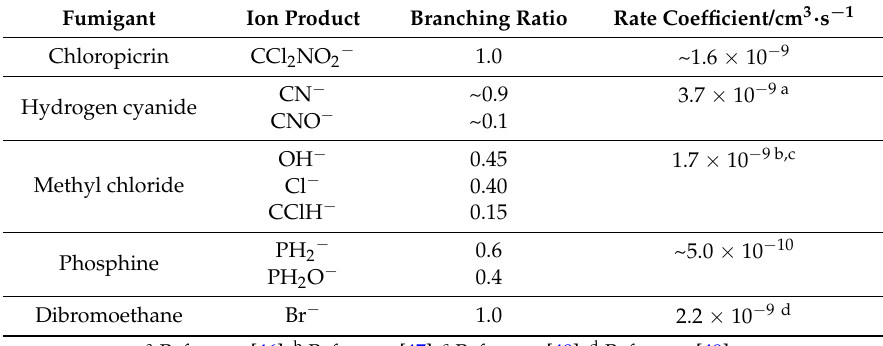
Table 1. O − reactions of fumigants, nitrogen carrier gas, and flow tube at 120 °C.